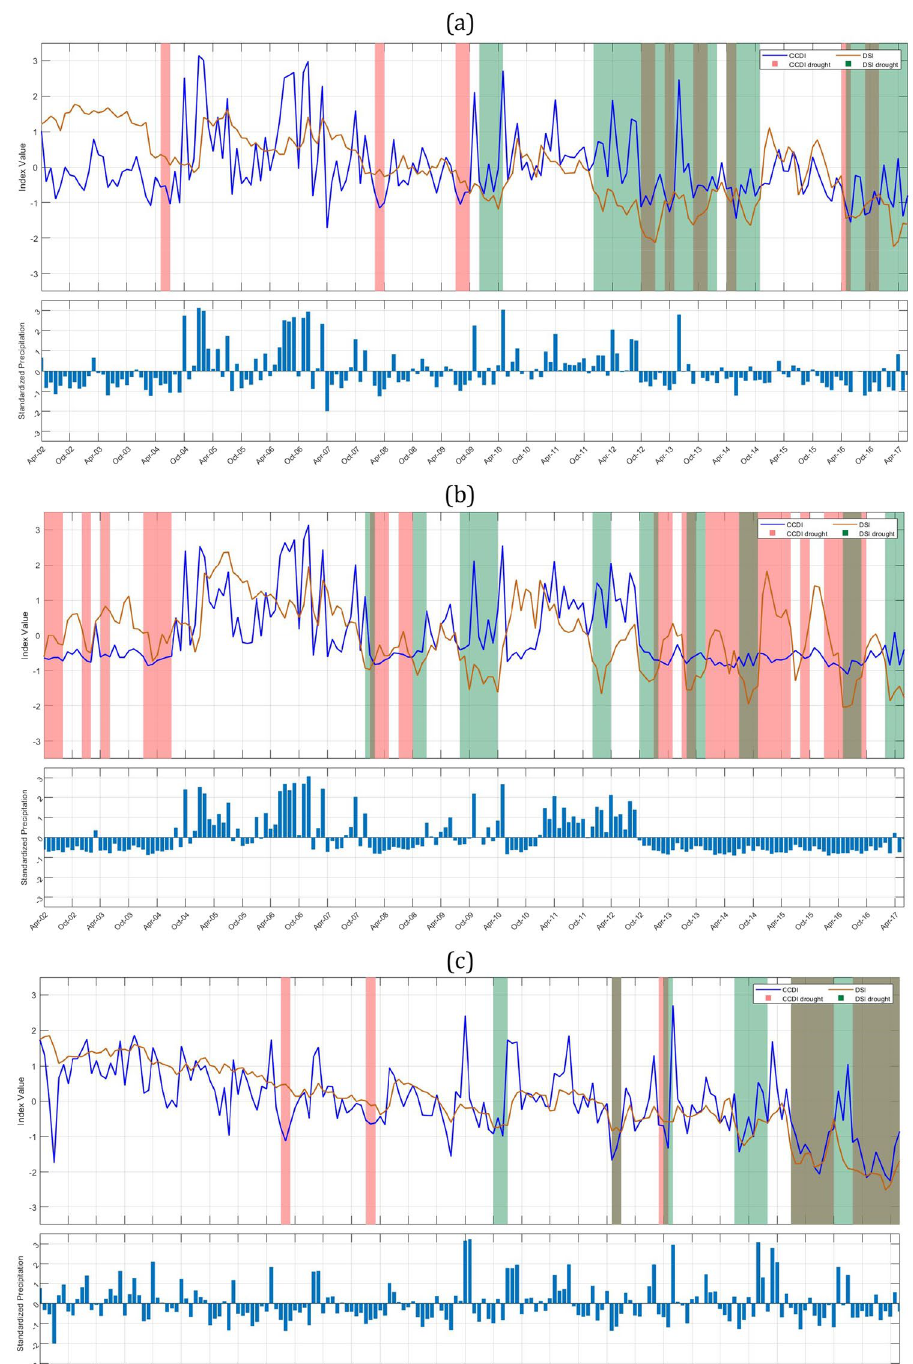
Figure 3. Time series of CCDI (blue line) and GRACE-DSI (orange line) are plotted along with the drought events identified based on CCDI (pink bands) and GRACE-DSI (green bands). The bottom bar graph shows the standardized precipitation variation over time (April 2002–June 2017). This plot is to understand whether the occurrence of drought is due to the deficit in precipitation, TWS, or both. ( a ) Indus Upper sub-basin ( b ) Shyok ( c ) Ramganga ( d ) Yamuna Upper ( e ) Area of North Ladakh not draining into Indus basin ( f ) Luni Upper ( g ) Luni lower ( h ) Saraswati ( i ) Sabarmati lower ( j ) Narmada lower